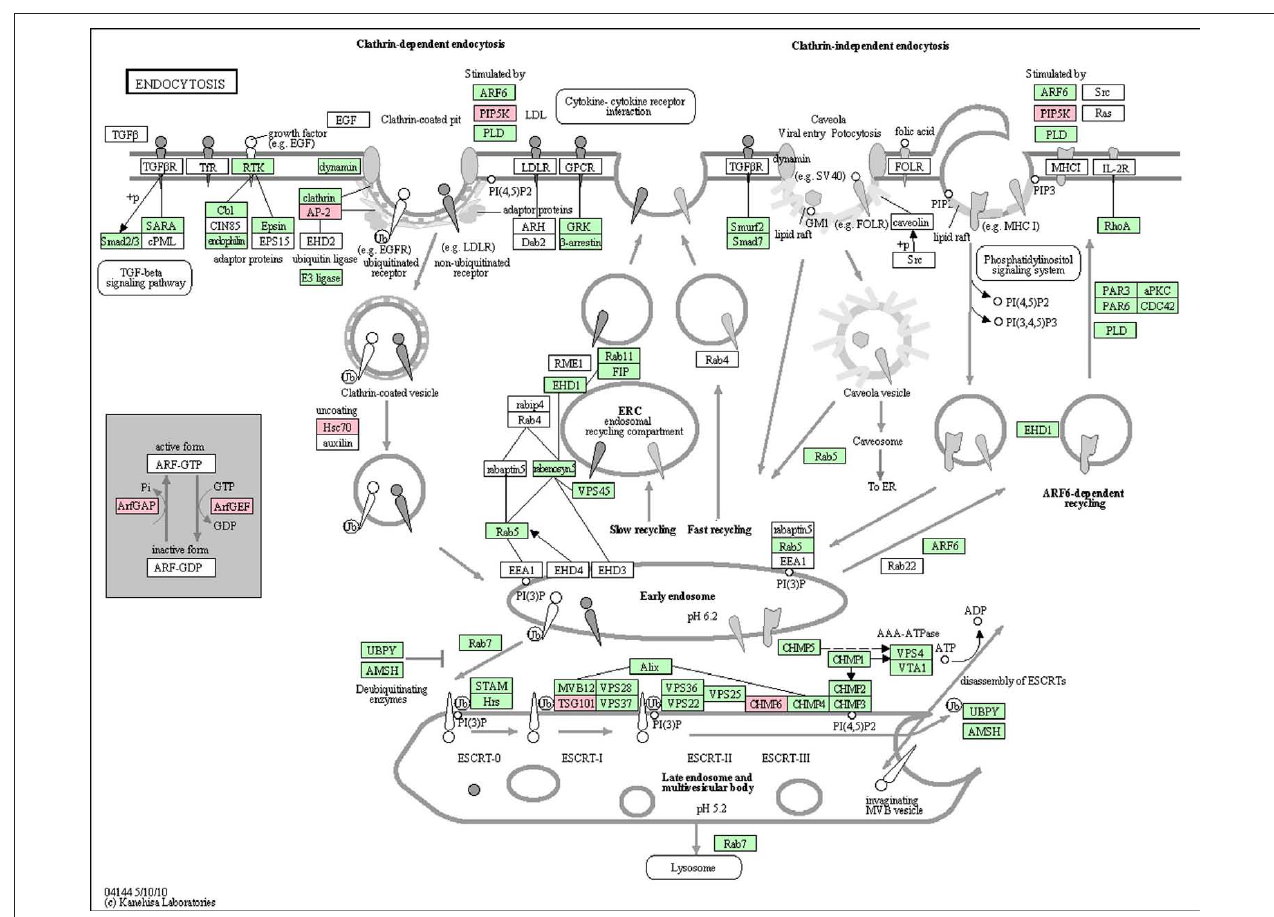
protein 101), Vps20 (Vacuolar protein sorting 20), alpha-Adaptin (CG4260 gene product from transcript CG4260-RA), cenG1A (centaurin gamma 1A), and schizo (K12495 IQ motif and SEC7 domain-containing protein). Green boxes represent other members in the pathway database for Drosophila melanogaster .